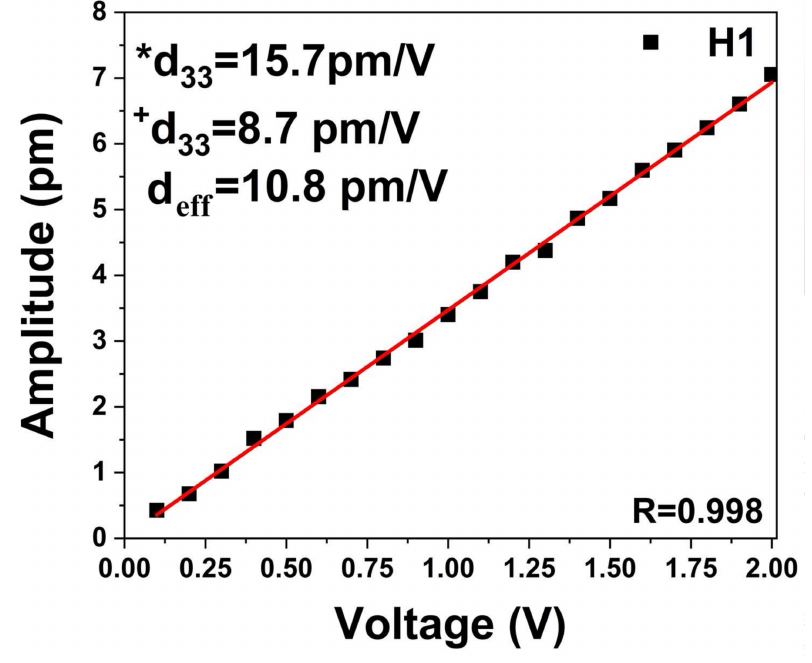
Figure 7. Representative voltage dependence of the amplitude of HA for H1.